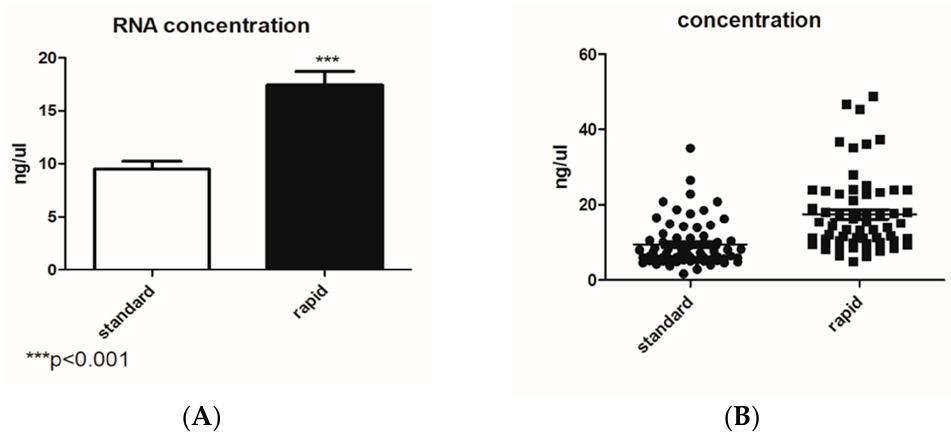
Figure 1. Comparison between the RNA concentration obtained by the standard and rapid extraction kits. ( A ) Statistical difference (*** p < 0.001); ( B ) the distribution of the analyzed samples ( N = 66 for each